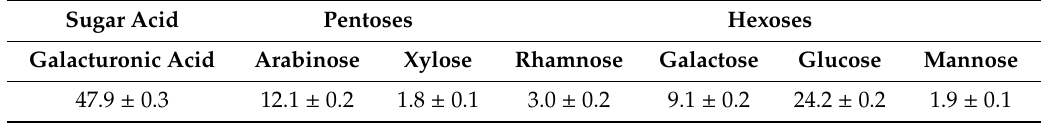
Table 4. Saccharide composition of strawberry fruit